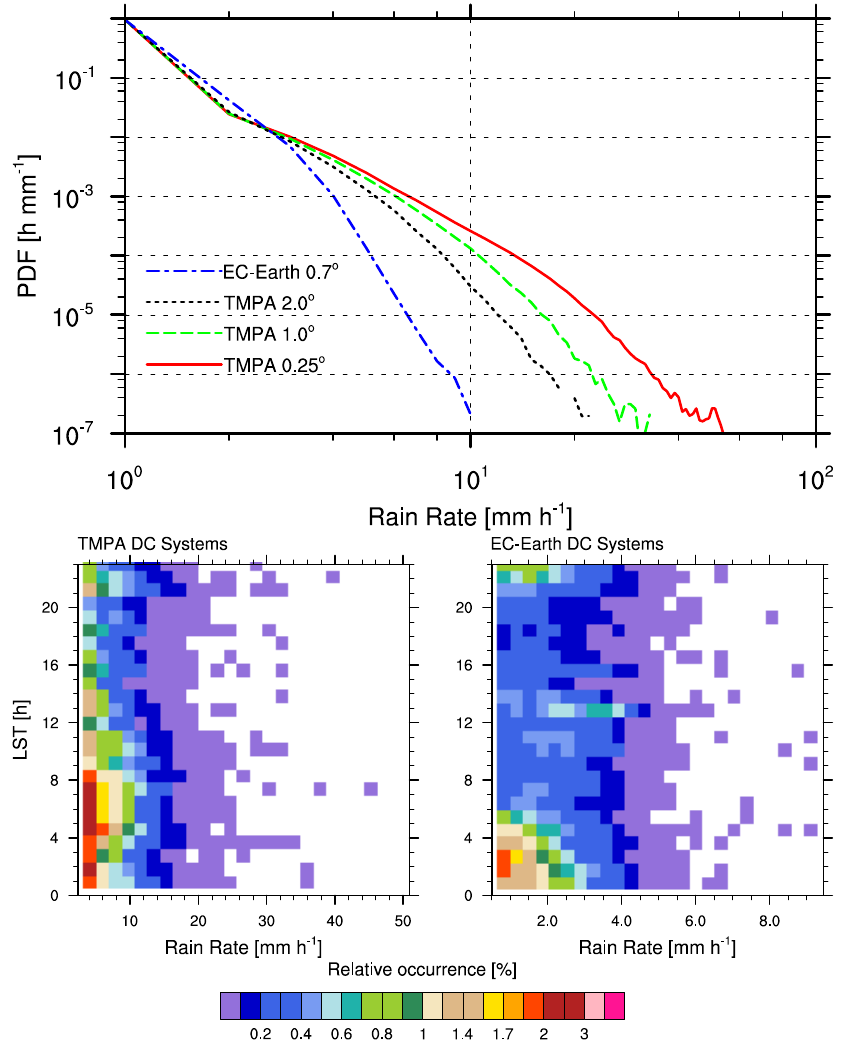
Fig. 2. Probability density functions (PDFs) (top) of the total precipitation over the central Pacific region. The curves are normalised by dividing the total number of cases in each bin by the bin size and the total number of valid data points. TMPA in its native resolution (red curve), re-sampled to 1 ◦ (green curve) and 2 ◦ (black curve), and the model (blue curve). Bivariate PDF of TMPA’s DC systems (bottom left) per LST, while the bottom right panel is the same but for EC-Earth. Note the different x axis ranges.